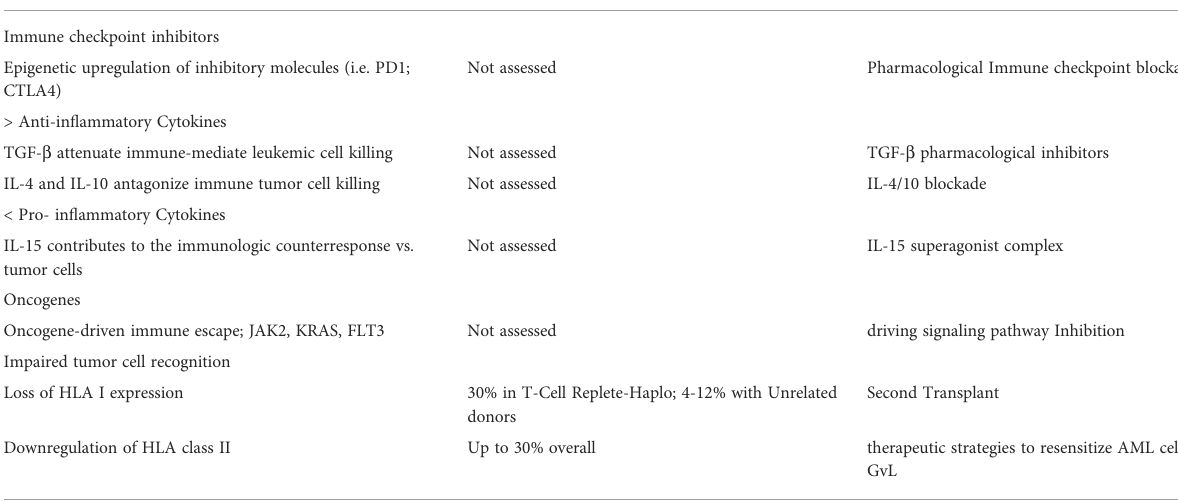
TABLE 1 Tumor Mechanisms of Immune Evasion after allogeneic